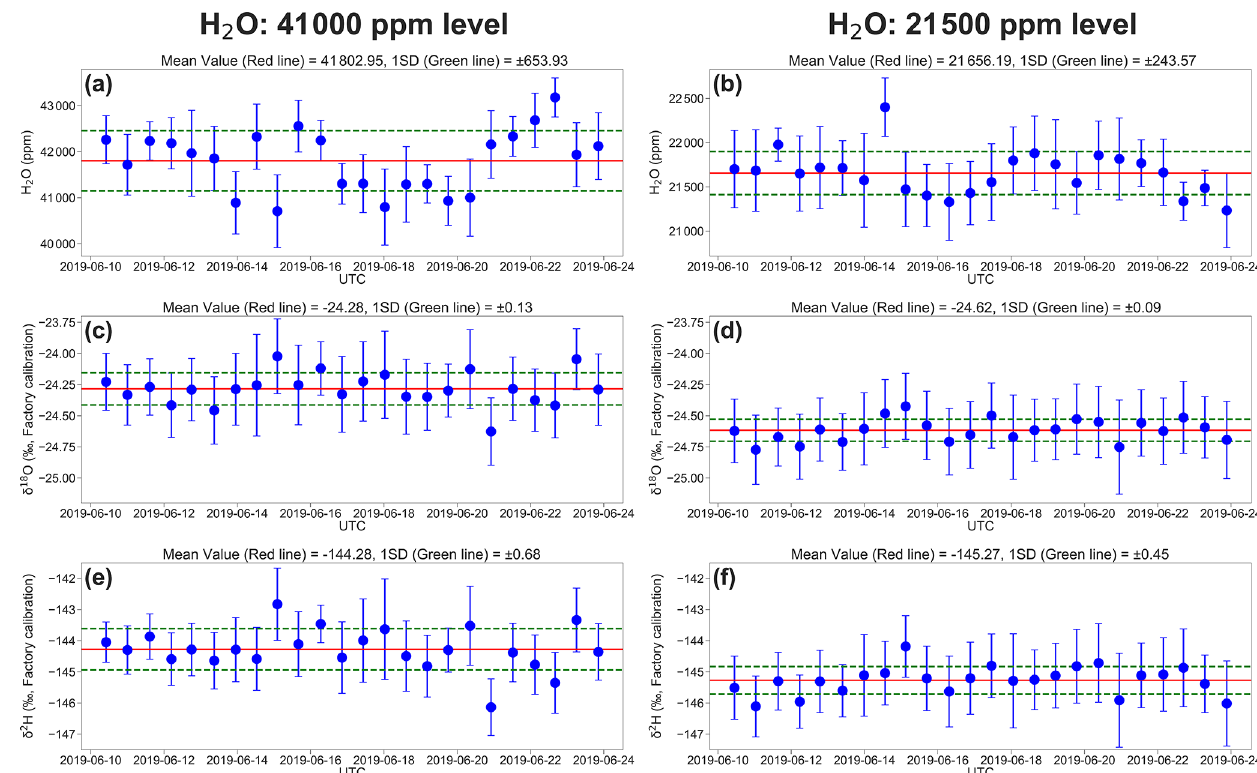
Figure 4. The 2-week evolution of the L2130i’s measurements for the DI1 standard water in (a) H 2 O concentration at the 41000ppm level, (b) H 2 O concentration at the 21500ppm level, (c) δ 18 O at the 41000ppm level, (d) δ 18 O at the 21500ppm level, (e) δ 2 H at the 41000ppm level, and (f) δ 2 H at the 21500ppm level. Each value is a 7min average of raw measurement data from the L2130i, and error bars are 1 standard deviation of 7min. The red and green lines show the average and standard deviation through the 2-week measurement period.